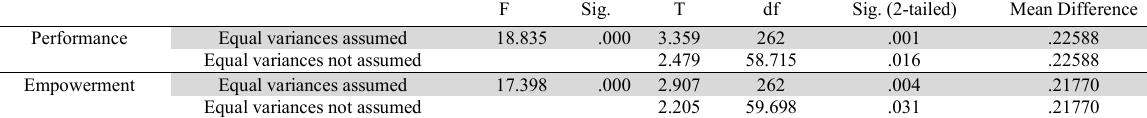
Independent Samples t-Test according to experiences